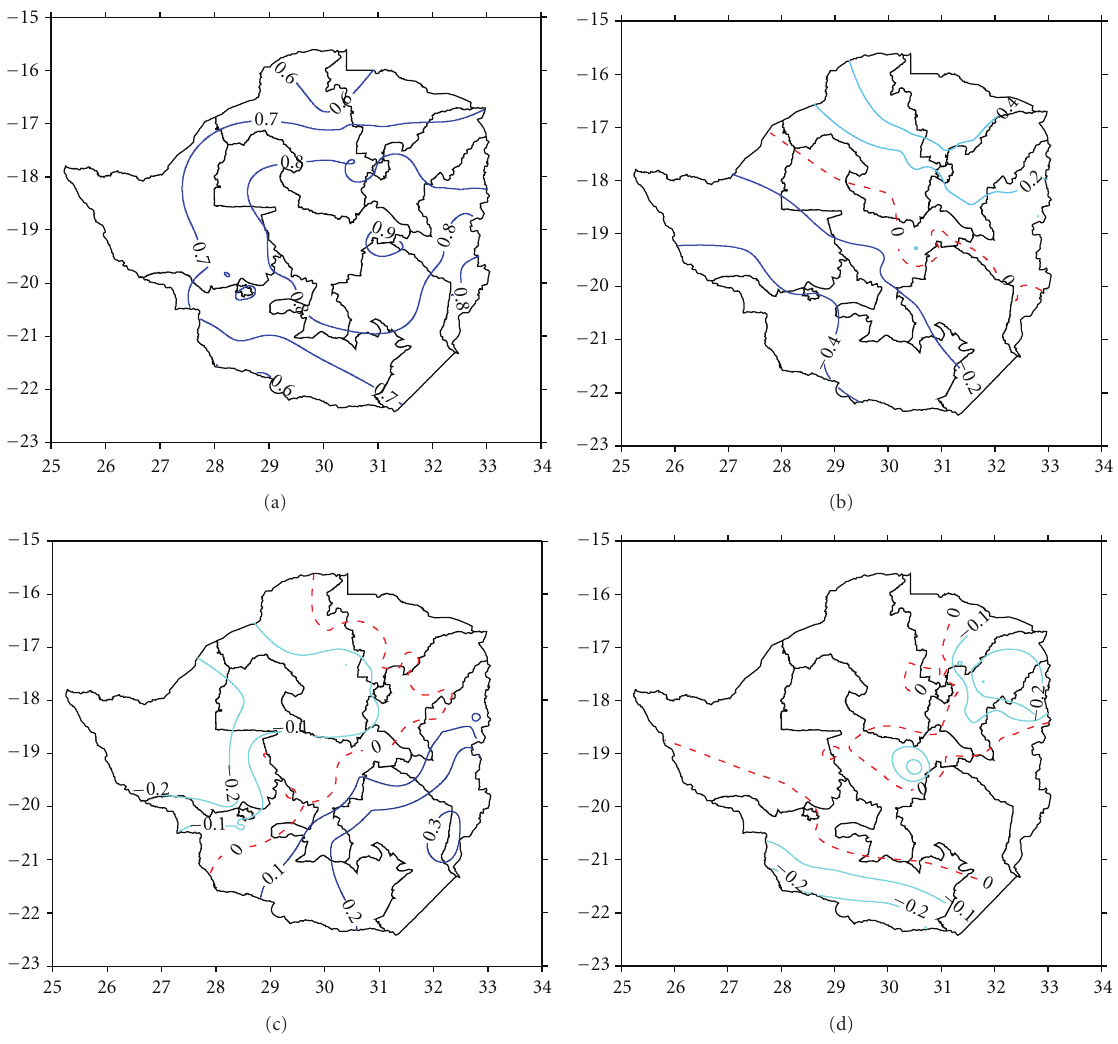
Figure 4: The spatial distribution of loading patterns of the (a) first, (b) second, (c) third, and (d) fourth PC of the 6-month SPI for the month of March. The zero isopleth is depicted by the broken red line, while positive and negative zones are indicated by dark and light blue